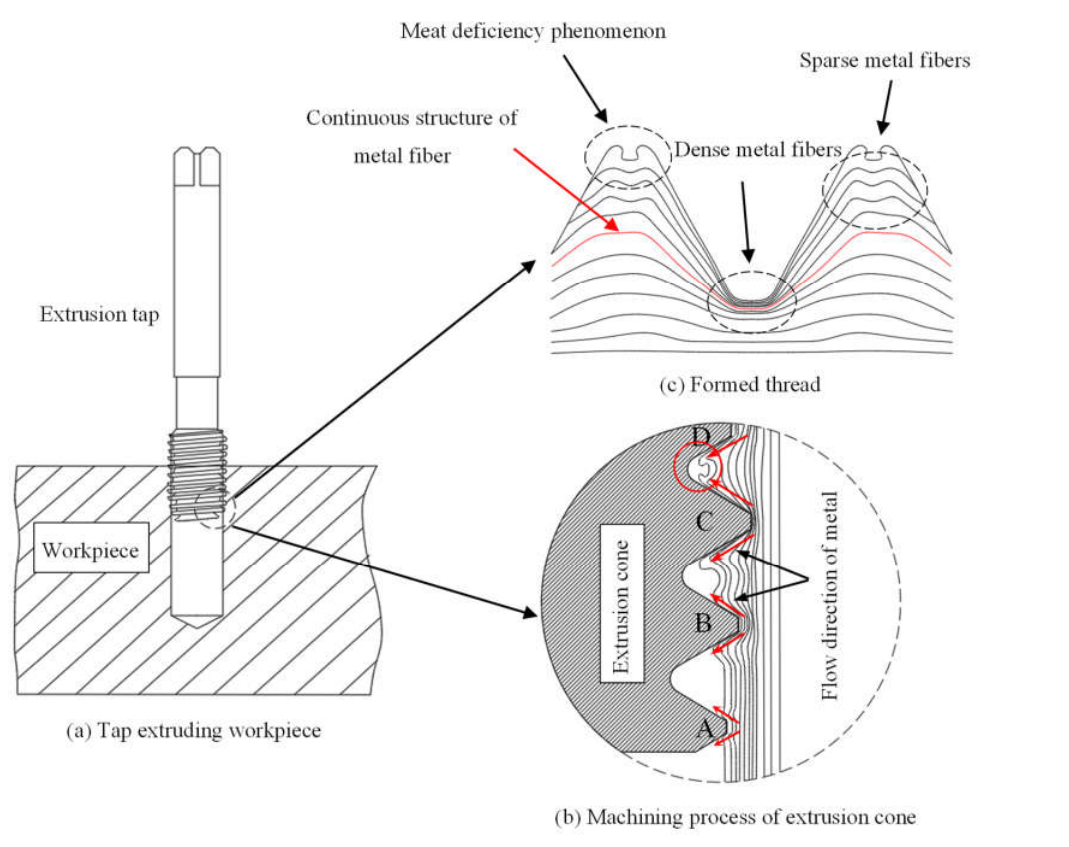
Figure 1. Schematic diagram of thread machining process.